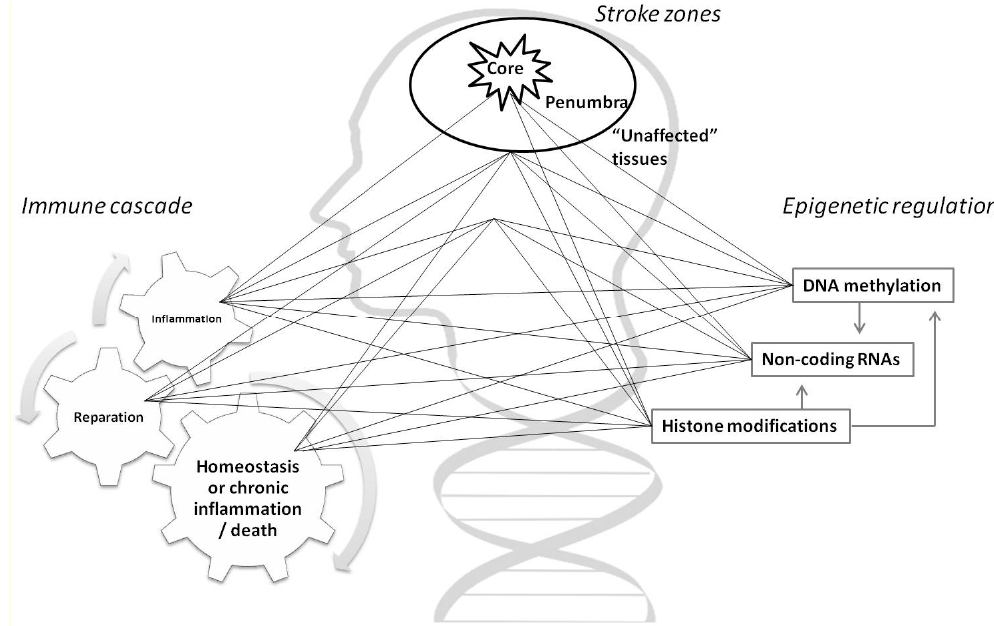
Figure 1. Spatio-temporal pattern of epigenetic regulation in immune response in stroke. The scheme is highlighting multidimensional relations of the immune system and epigenetic mechanisms in di ff erent stroke zones over time. Stroke is unequally a ff ecting brain tissues, with irreversible neuronal damage in stroke core and metabolic changes with the possibility counteract tissue injury in the penumbra area. Additionally, stroke is provoking immune response leading to inflammation and starting an immune cascade with consequences not only in the brain but also in the whole organism. Alteration of immune function is conducted through complex epigenetic regulation which is sensitive to temporal changes in the tissue microenvironment.